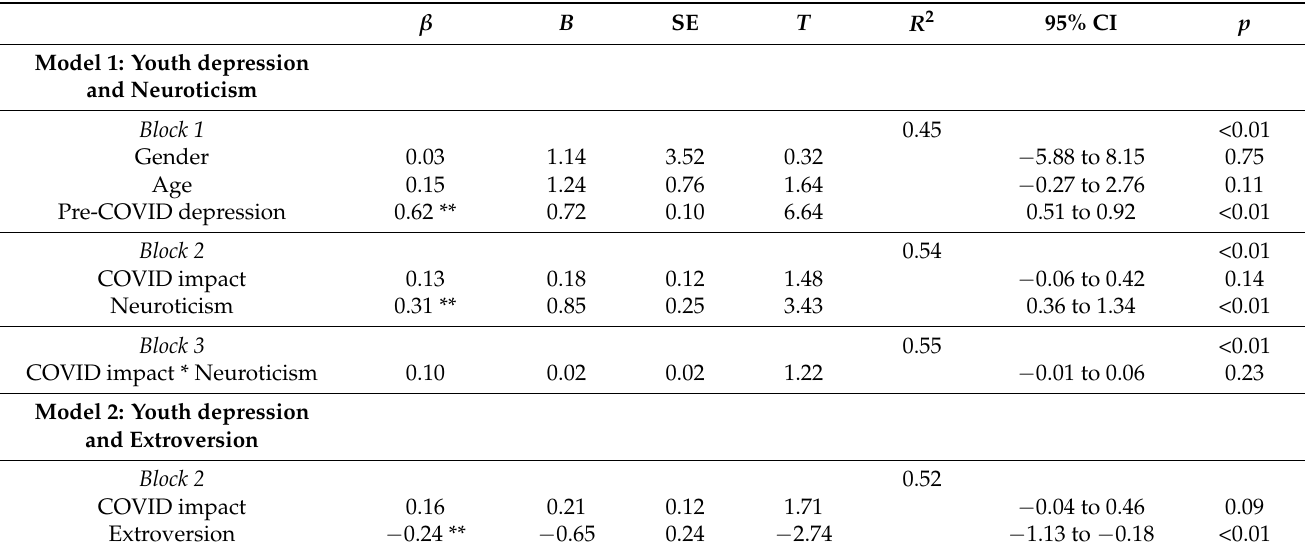
Table 3. Regression models predicting youth pain and mental health during the COVID-19 pandemic. β B